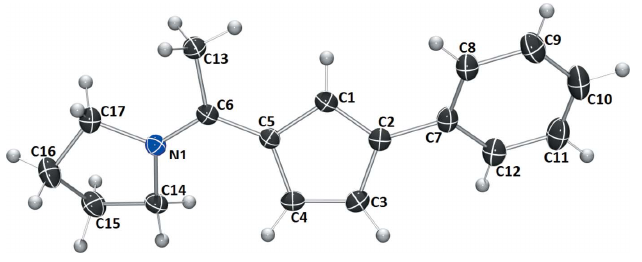
Figure 1 The molecular structure of the title compound. Displacement ellipsoids are shown at the 50% probability level.